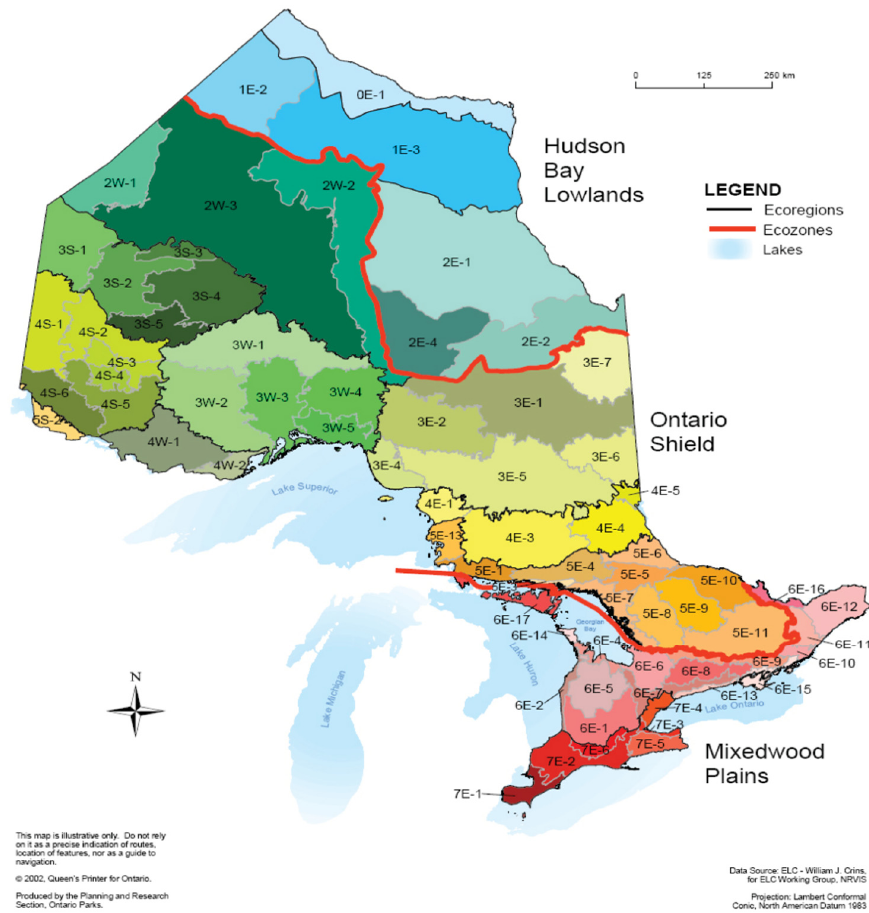
Figure A1. The ecozones, ecoregions and ecodistricts of Ontario [3].